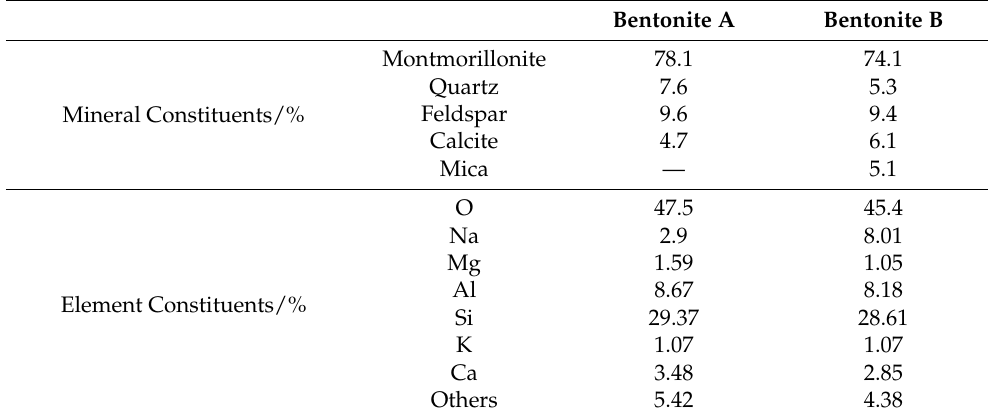
Table 1. Basic constituents of bentonite.